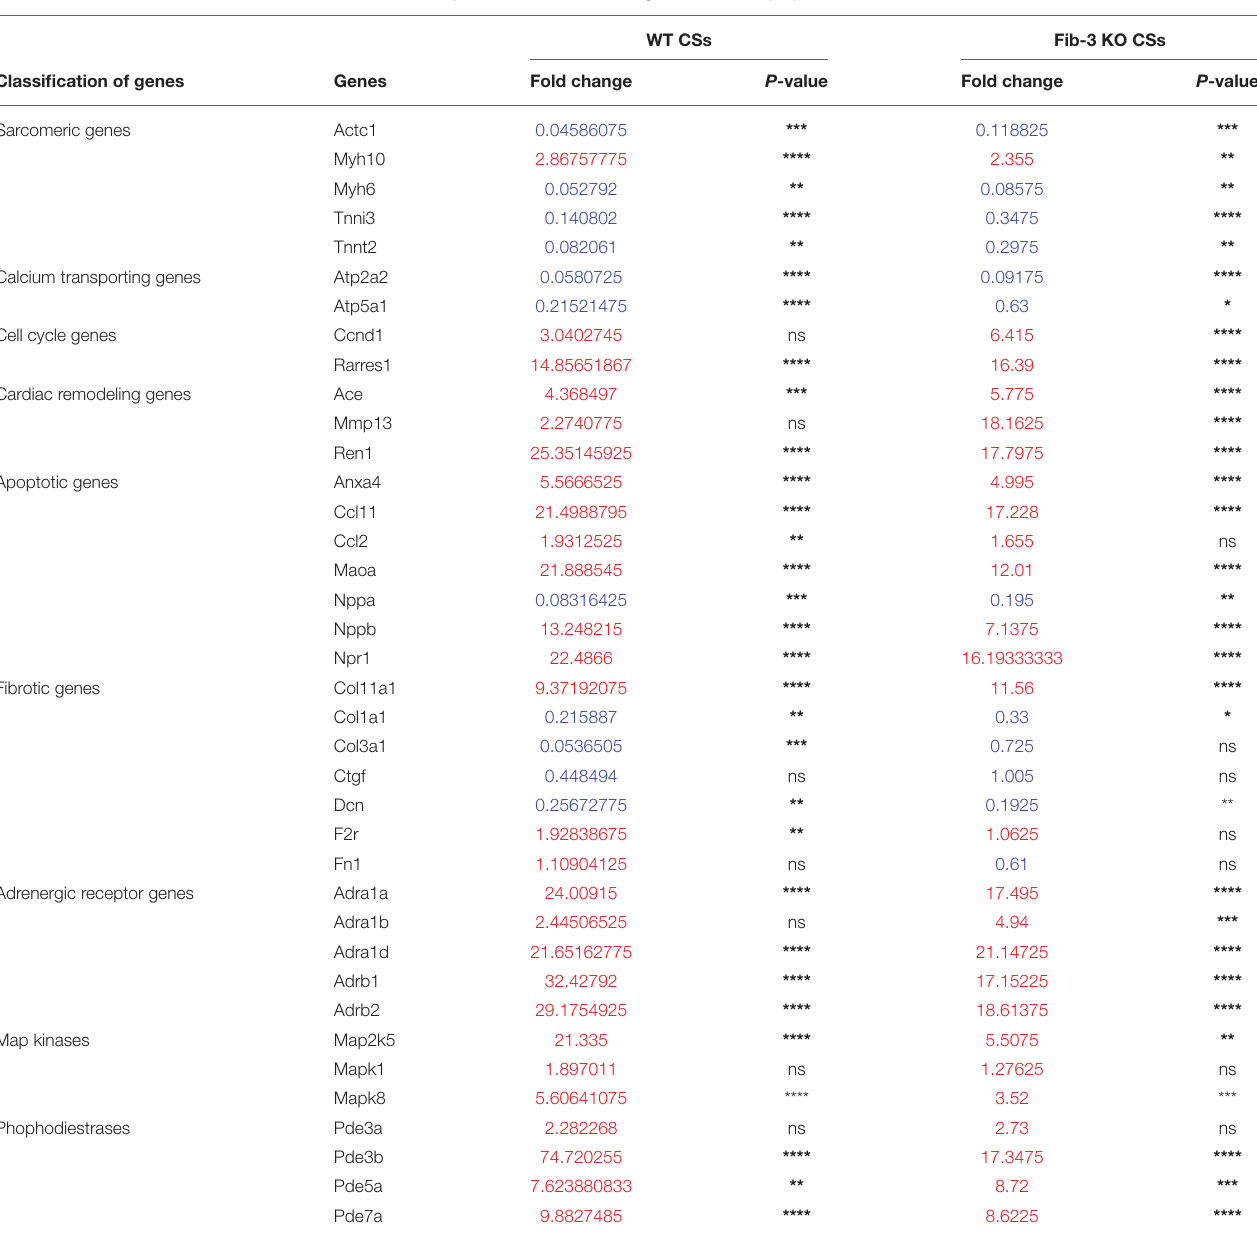
TABLE 1 | Expression of cardiovascular genes following I/R